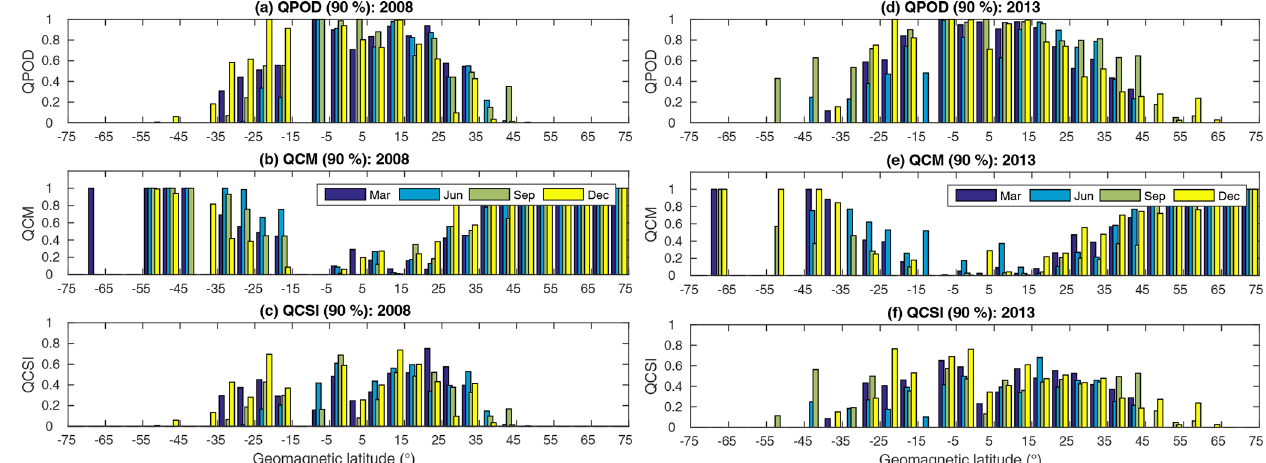
Figure 13. The QPOD, QCM, and QCSI categorical metrics at 90% for 2008 (a–c) and 2013 (d–f) for the months of March, June, September, and December based on observations from the GPS receiver stations given in Fig.